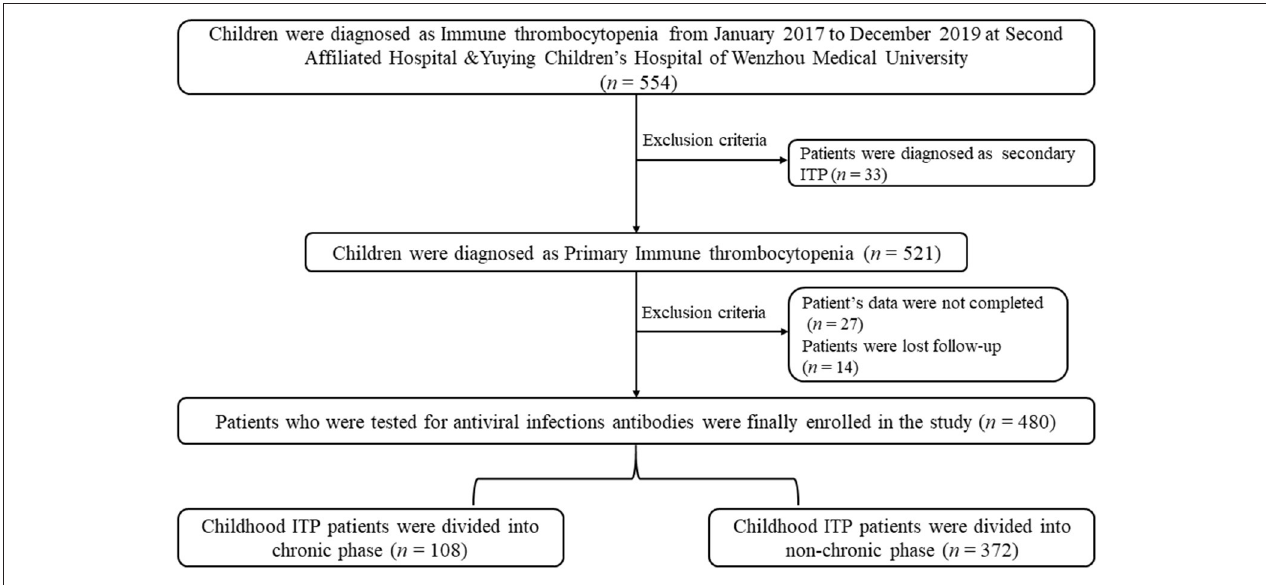
FIGURE 1 | Study design and algorithm for deciding on which patients to include in our study.